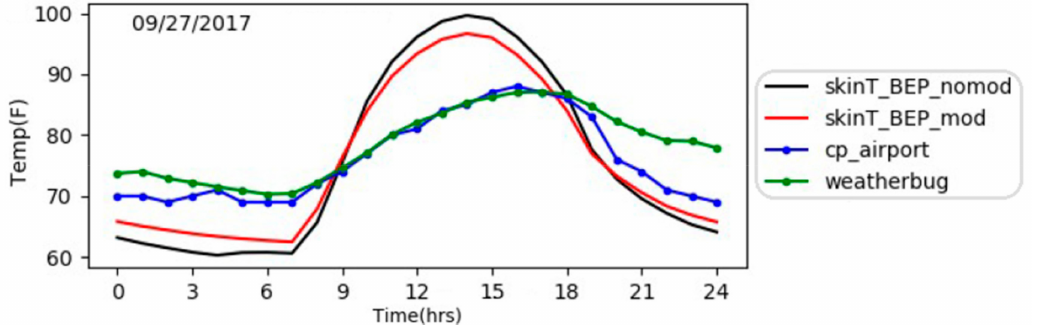
Figure 10. Skin temperature simulations and measurements for one overcast day. The unit is ◦